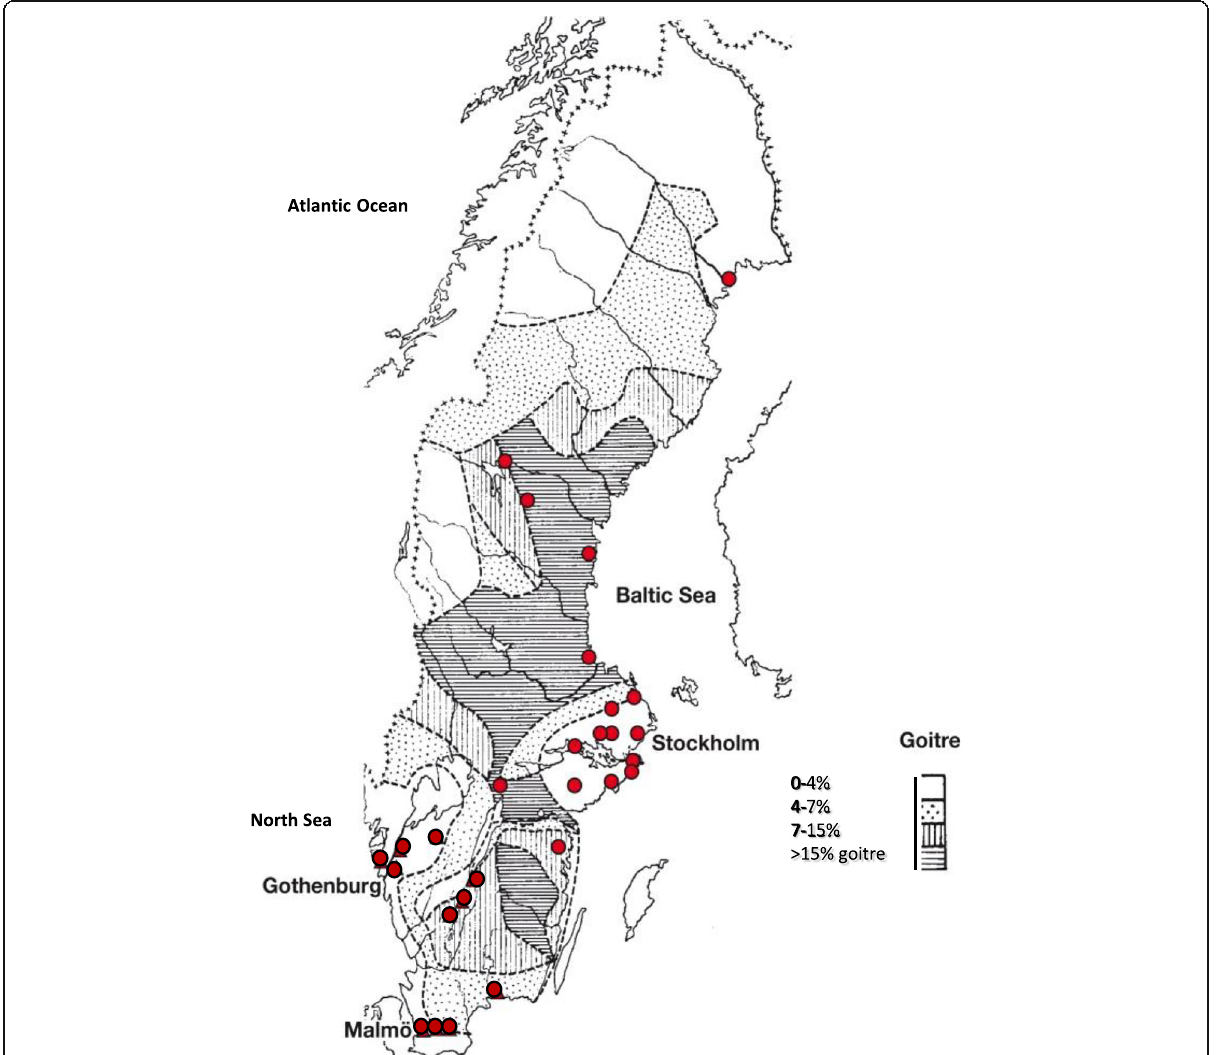
Fig. 2 The frequency of goitre in Sweden in 1929. The dark grey shaded areas represent the goitre belt. Circles mark location of 30 randomly selected